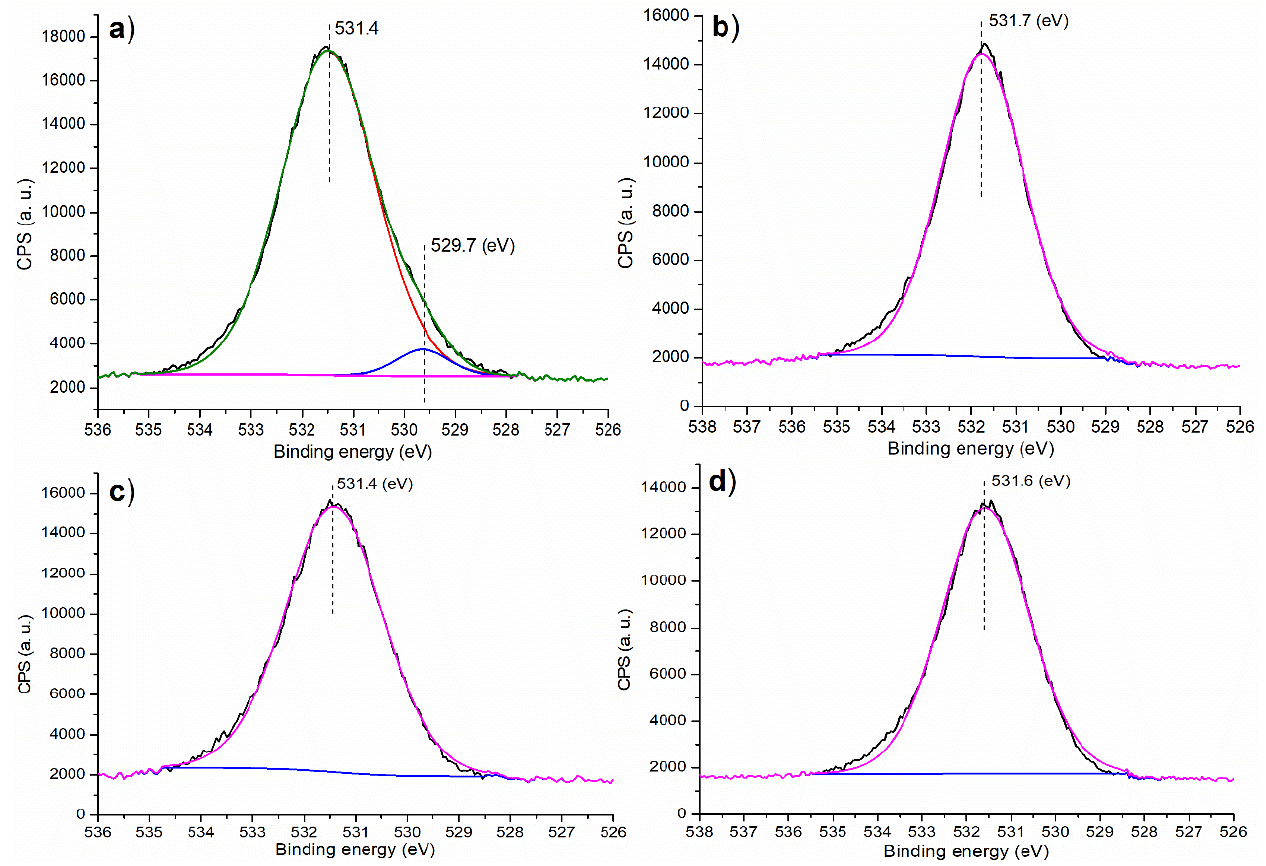
Figure 6. XPS measurement of the O 1s region: ( a ) Cement, ( b ) sample 2, ( c ) sample 7, and ( d ) sample 10.